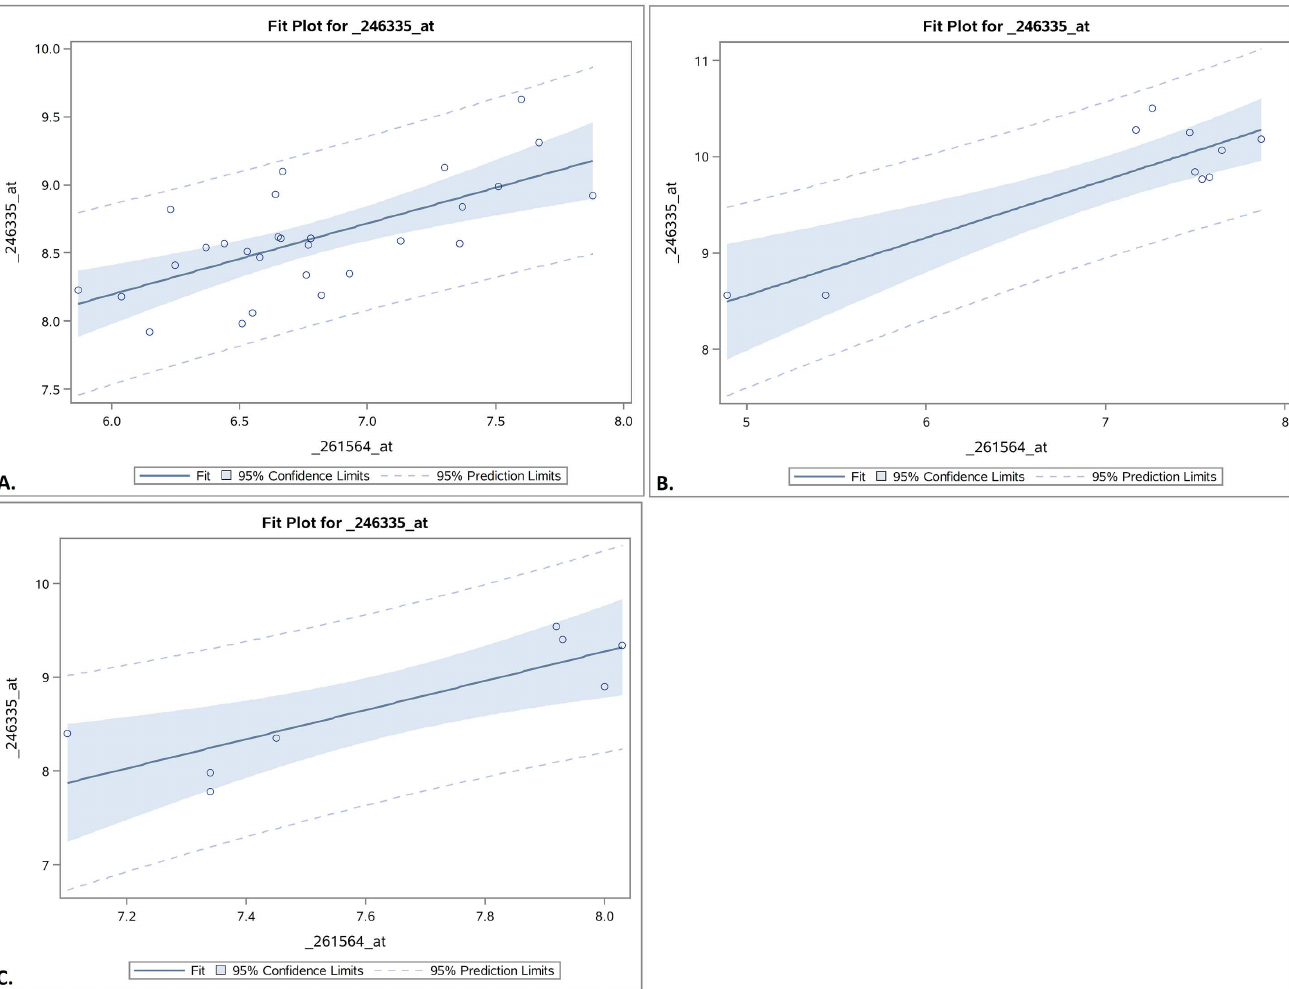
PLOS ONE | DOI:10.1371/journal.pone.0162327 September12,